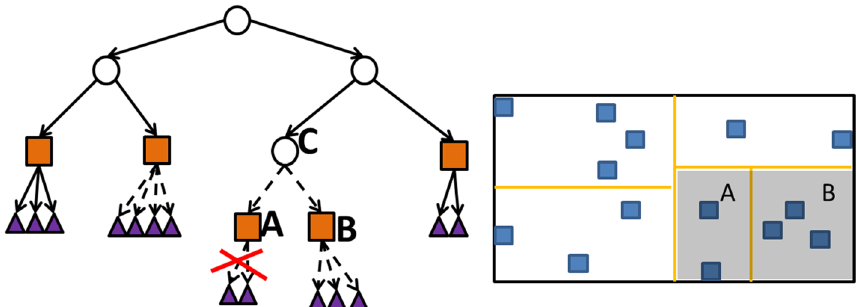
Fig. 8 The instance of deleting leaf nodes in 2D SKDTree. On the left side of figure 8 is an SKDTree corresponding to the data spaceon the right. In the SKDTree, non‑leaf nodes are represented as hollow circles,sub‑leaf nodes as orange squares, and leaf nodes as purple triangles. In the rightside, the gray shaded part are in line with non‑leaf node